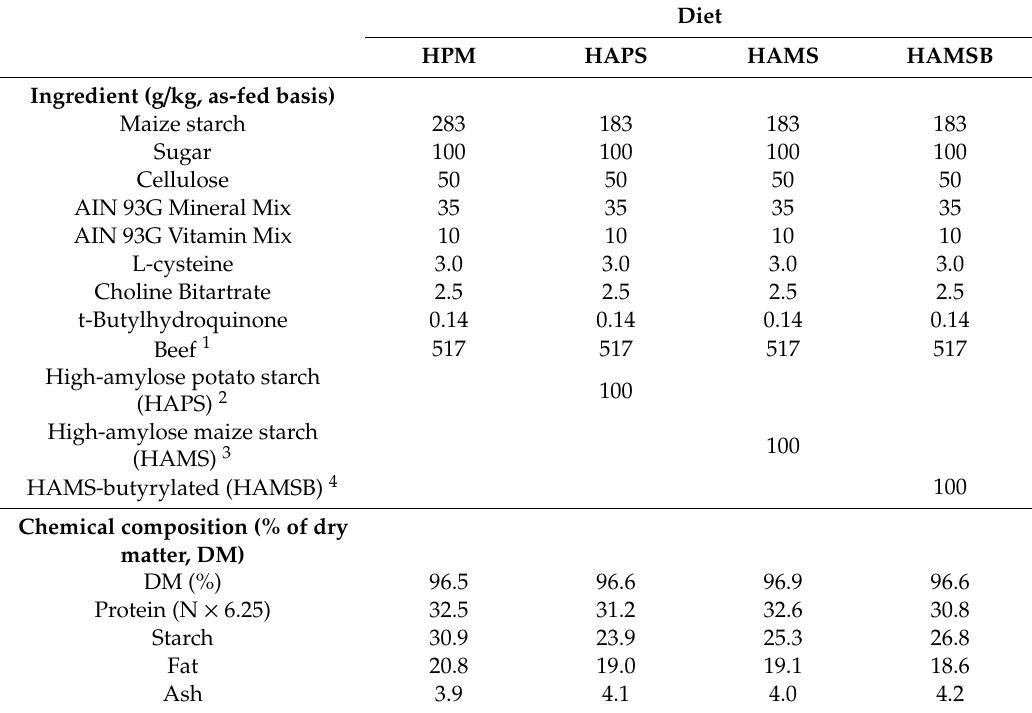
Table 3. Ingredients and analyzed chemical composition of the four experimental diets. Diet HPM HAPS HAMS HAMSB Ingredient (g / kg, as-fed basis) Maize starch 283 183